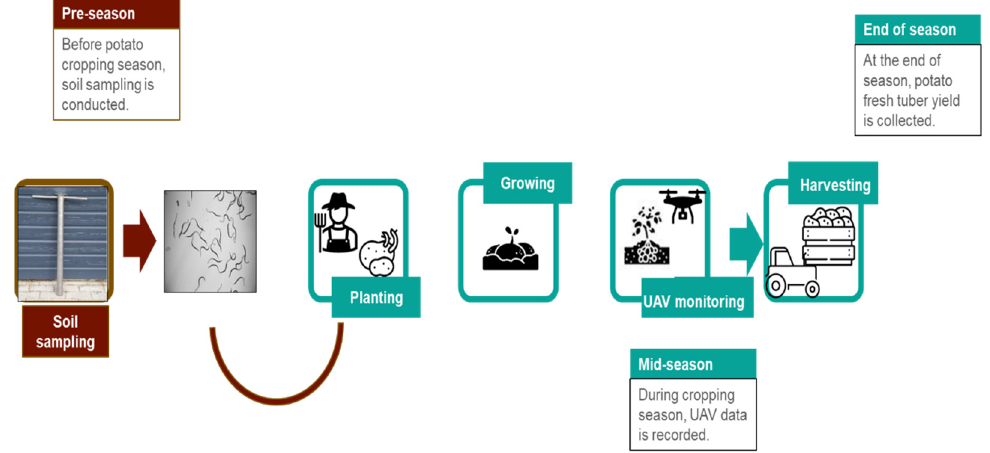
Figure 1. The flow chart of the techniques used in assessing the relationship between explanatory variable P i in eggs (g dry soil) − 1, and measured dependent variables (fresh tuber yield, normalized difference vegetation index (NDVI), normalized difference red edge (NDRE), weighted difference vegetative index (WDVI), chlorophyll, and canopy temperature).